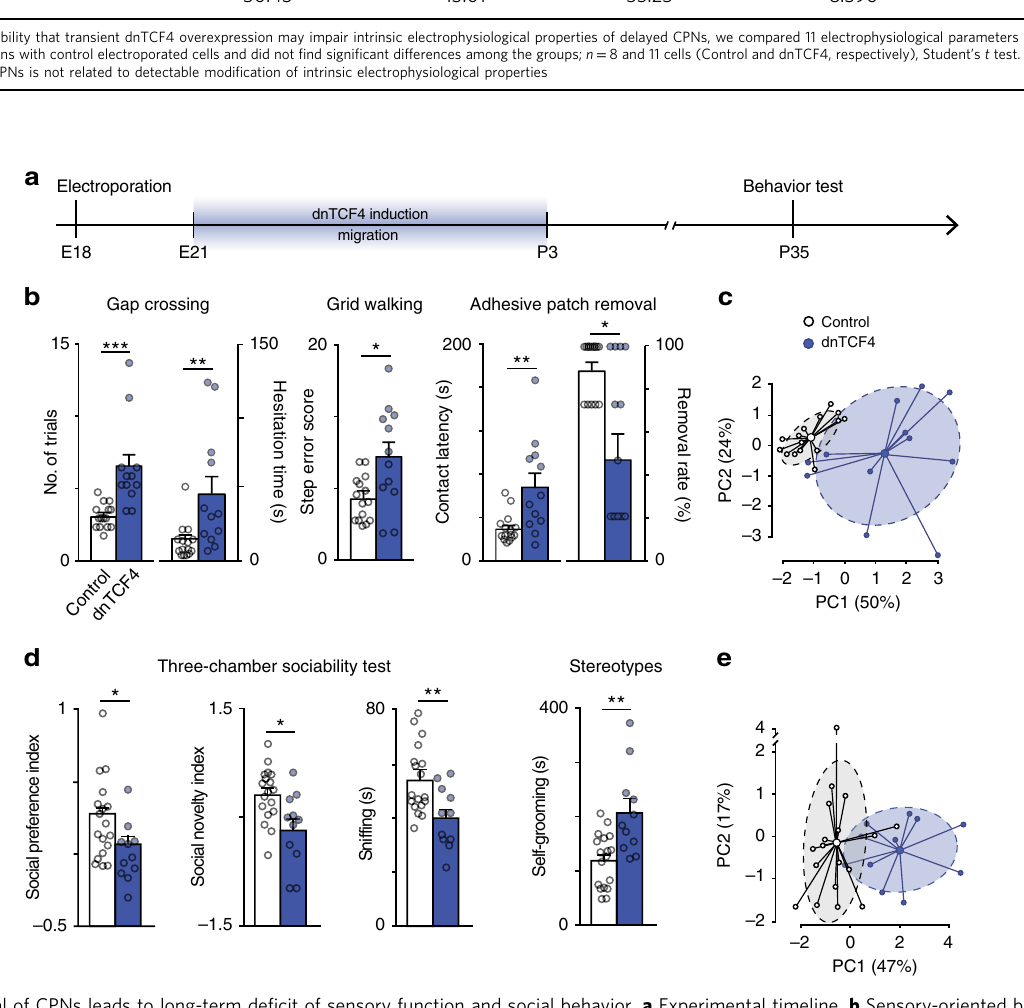
(Supplementary Fig. 7b) did not support associated locomotor de fi ciency either. As dnTCF4 animals clustered apart from con- trols by PCA on behavioral variables (Fig. 6c), our data were consistent with a general de fi cit in somatosensory function.